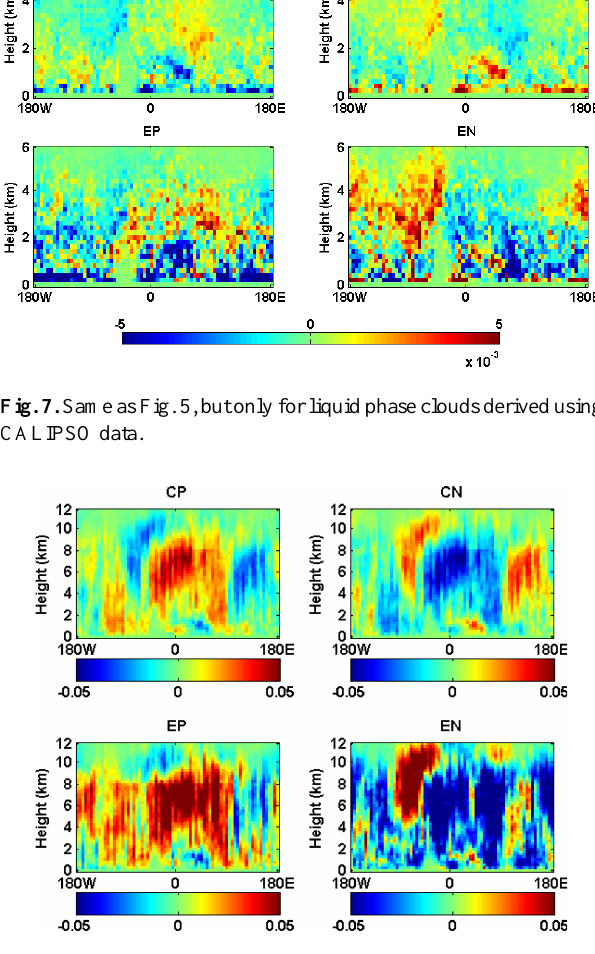
Fig. 8. Same as in Fig. 4, but using combined CloudSAT-CALIPSO